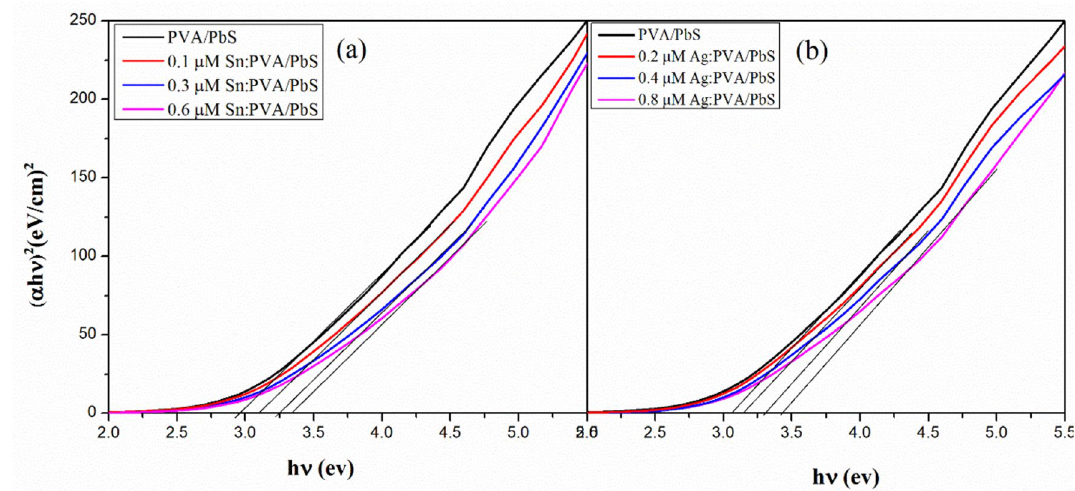
2 Figure 6. Variation of (α h ν) with photon energy for ( a ) Sn doped PbS/PVA and ( b ) Ag-doped PbS/PVA with pure